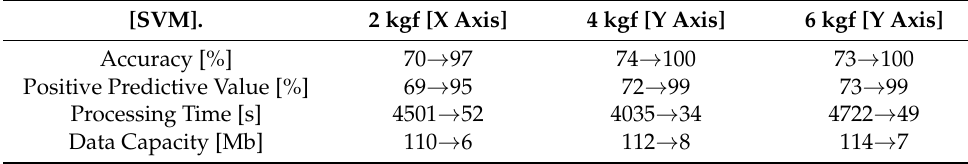
Table 20. Simultaneous fault diagnosis result based on big data and smart data.